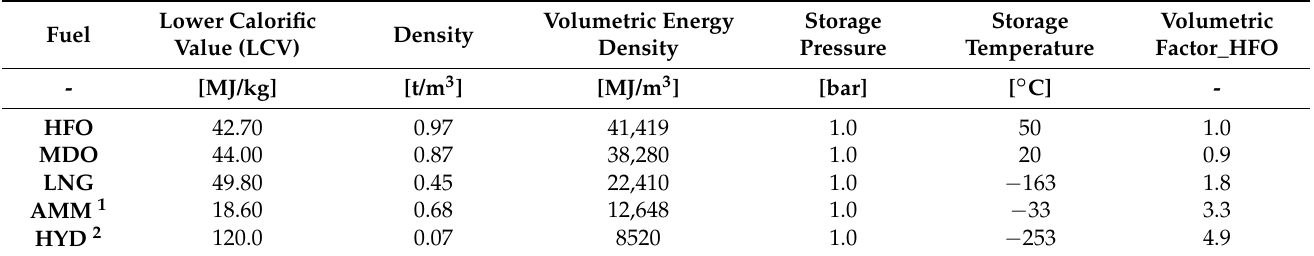
Table 1. Comparison between fuels